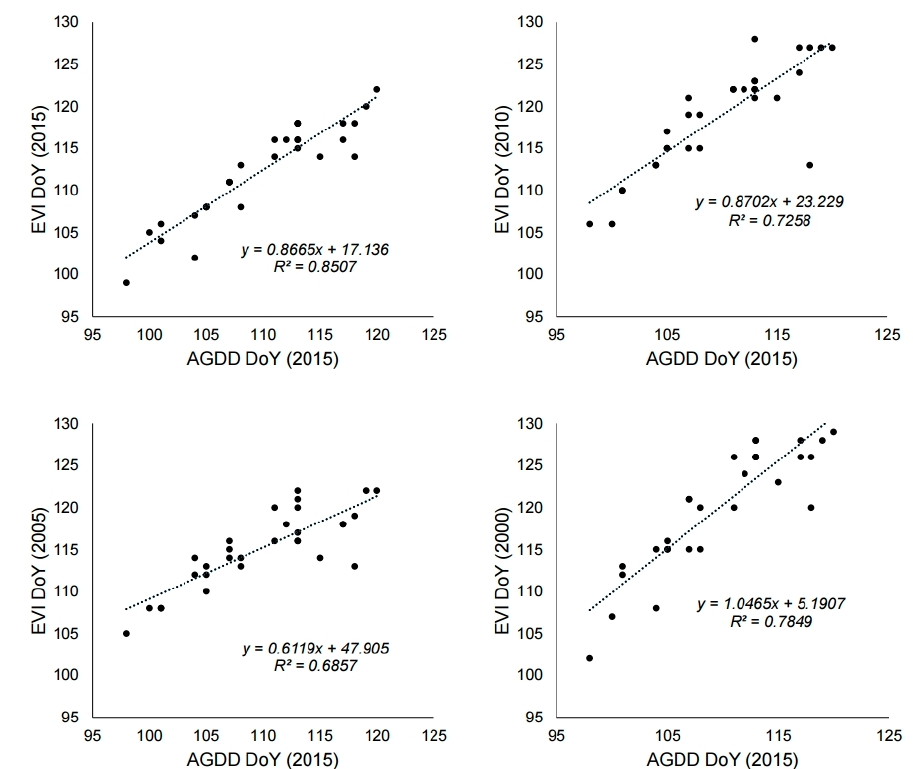
Figure 5. The relationship between the AGDD DoY and the enhanced vegetation index (EVI) DoY for 30 sampling sites of Mongolian oak forests in South Korea. Green-up DoY deducted based on AGDD in 2015 showed significant correlation with green-up DoY deducted based on EVI in 2000, 2005, 2010, and 2015.